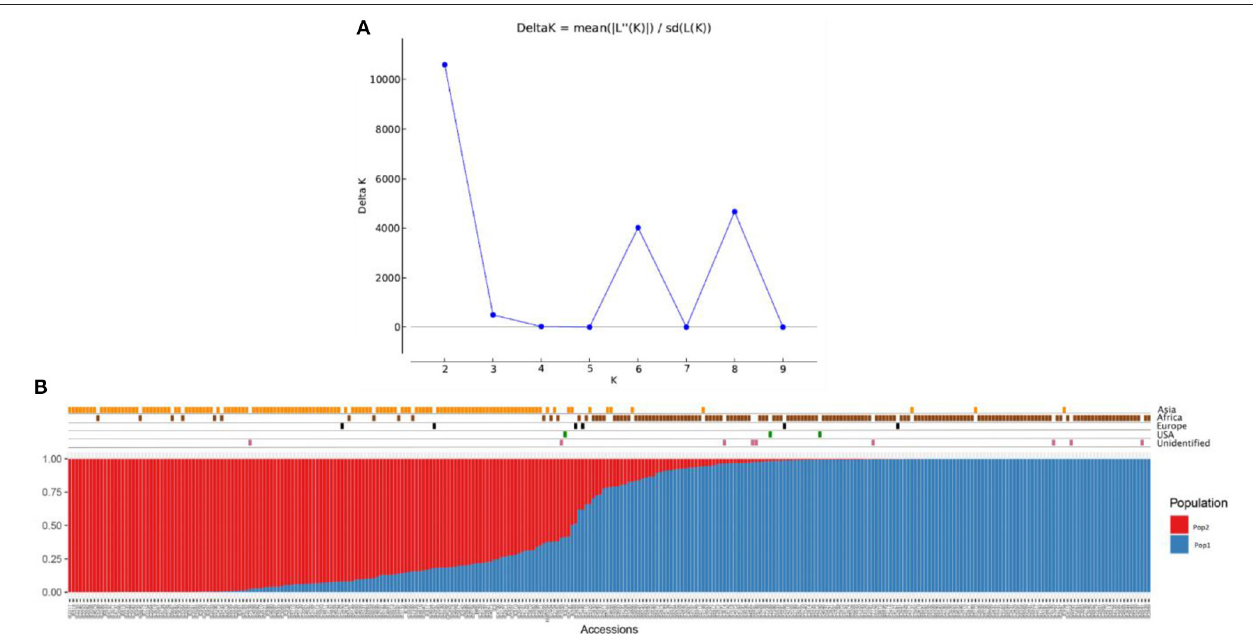
FIGURE 5 | Population structure analysis of the finger millet diversity panel based on DArTseq markers: (A) Delta K- based on the rate of change in [LnP (D)] between successive K-values of populations and (B) estimated population structure at K = 2 on geographical regions.